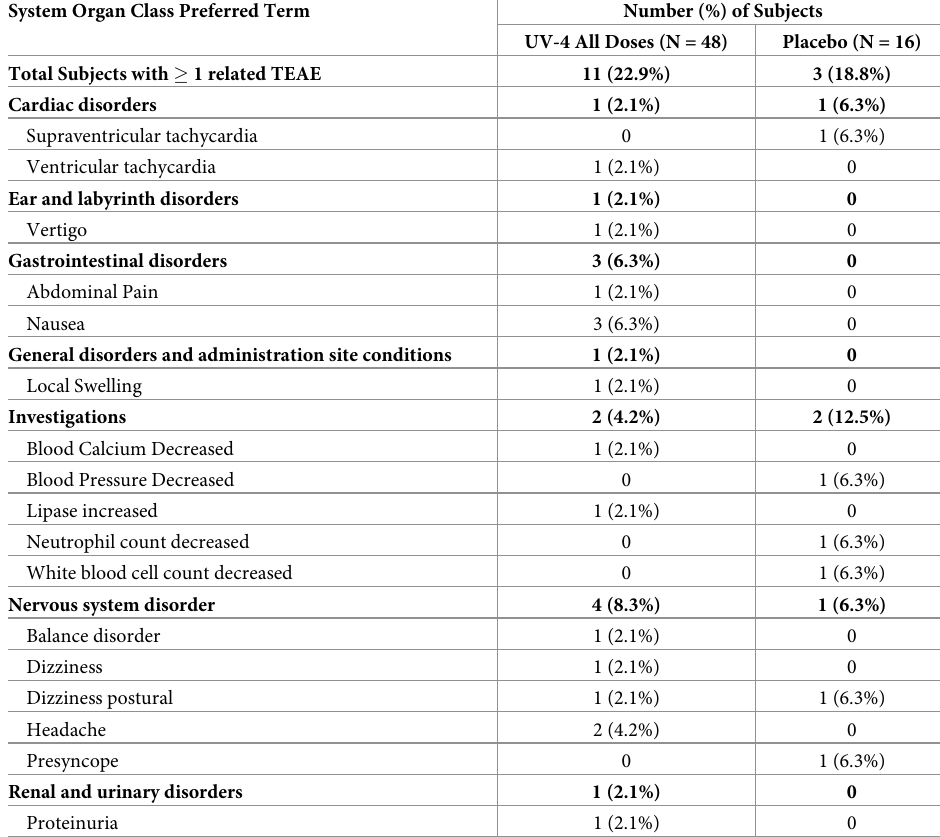
Table 4. Number of Subjects with Related Treatment-Emergent Adverse Events by System Organ Class and Pre- ferred